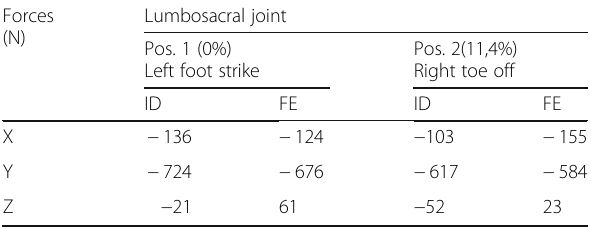
Table 3 Reaction forces at lumbosacral joint Forces Lumbosacral joint (N)